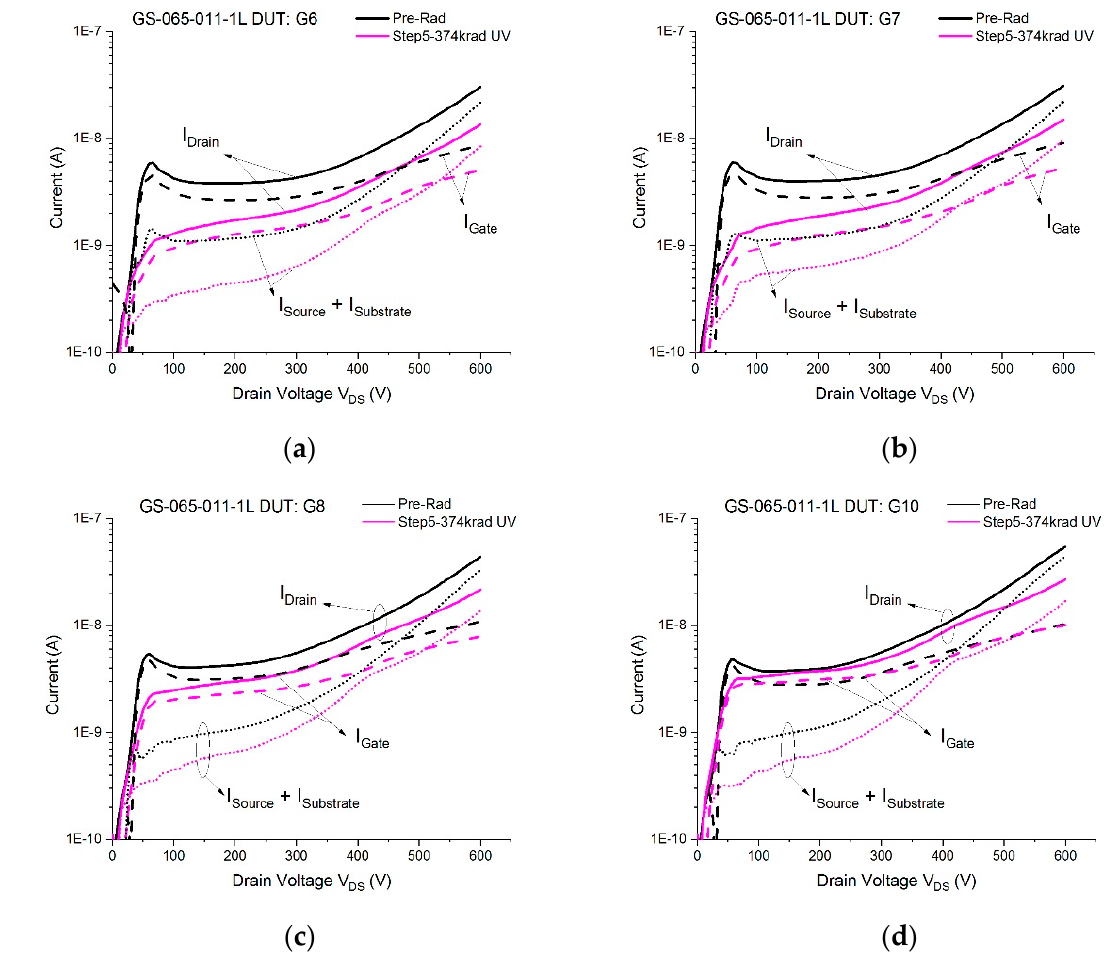
Figure 8. The leakage currents versus drain voltages in the off state (V GS = 0 V) before (black lines) and after (magenta lines) gamma radiation with a total ionising dose of 374 krad(SiO 2 ) at a base temperature of 53 °C. ( a ) Device G6 stressed during irradiation with V DS = 500 V and V GS = − 5 V. ( b ) Device G7 stressed during irradiation with V DS = 500 V and V GS = − 5 V. ( c ) Device G8 stressed during irradiation with V DS = 500 V and V GS = 0. ( d ) Device G10 stressed during irradiation with V DS = 500 V and V GS = 0